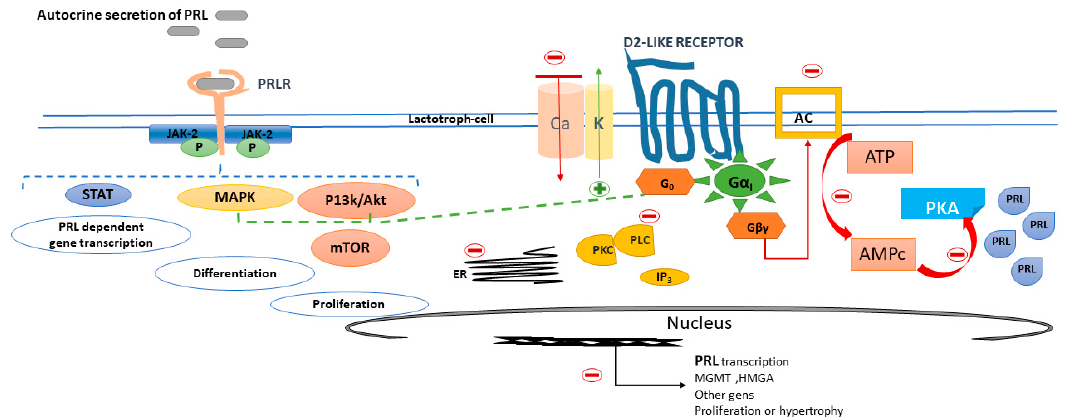
Figure 3. Prolactin and dopamine receptor in the lactotroph cell. After dopamine binding to dopamine receptor type 2, K+ channels are activated and adenylyl cyclase activity is inactivated, resulting in the suppression of PRL gene expression, lactotroph proliferation and a decrease in the size of hypertrophied lactotrophs. D2 via G0 also activates phosphatidylinositol 3-kinase (PI3K), and mitogen-activated protein kinase (MAPK) pathways to prevent lactotroph proliferation. The autocrine released prolactin binds to the prolactin receptor and, via the Janus kinase-2-signal transducer and activator of transcription-5 (JAK2-STAT5), (PI3K-Akt-mTOR) or the MAPK pathways, mediates changes in transcription, differentiation and proliferation.